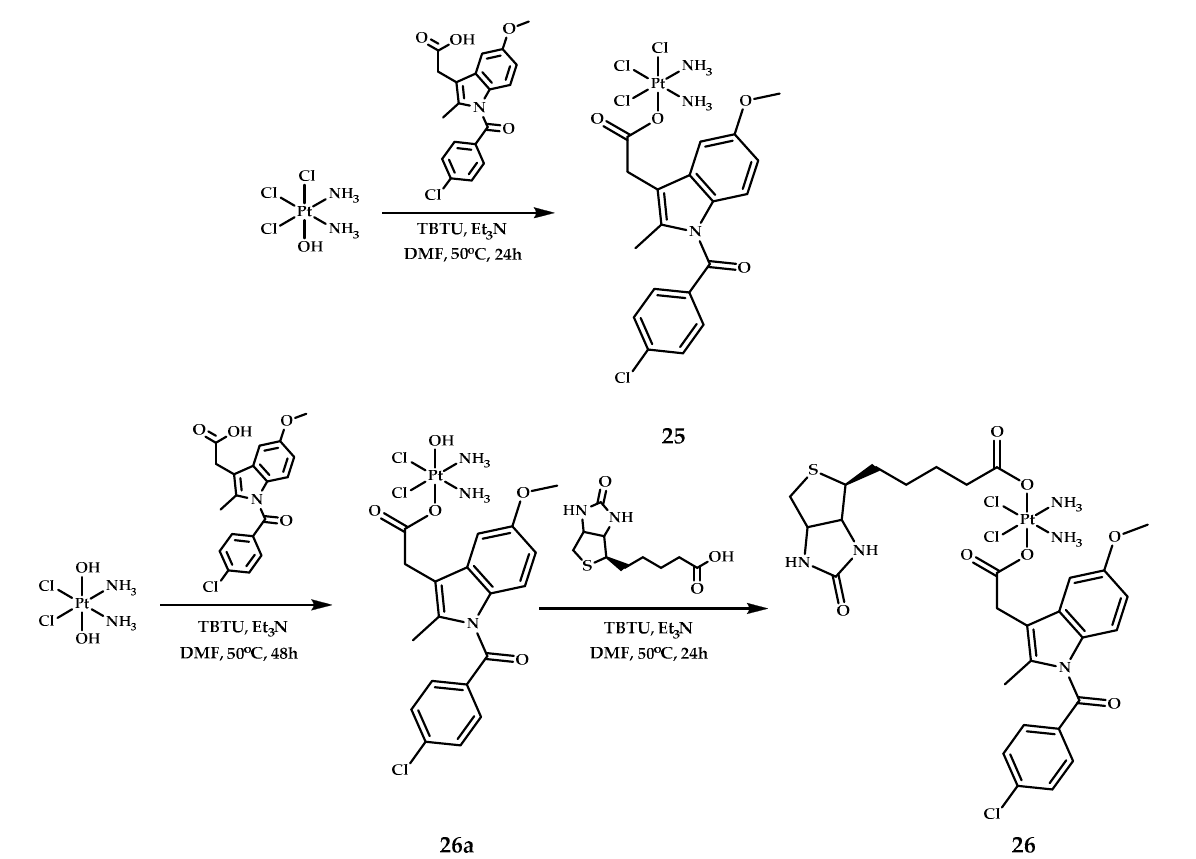
Figure 12. Cisplatin-based platinum(IV) prodrugs 25 , 26a , and 26 with indomethacin and biotin as axial ligands. Table 13. Antiproliferative activity of cisplatin and platinum(IV) prodrugs 25 and 26 on HCT-116 (colorectal cancer), HepG-2 (hepatocellular carcinoma), PC-3 (prostate carcinoma), LO-2 (normal liver), EA.hy926 (umbilical vein endothelial cell), SGC7901 (gastric cancer), and SGC7901/CDDP (cisplatin-resistant gastric cancer) cell lines. Rf: ratio of IC 50 value for a